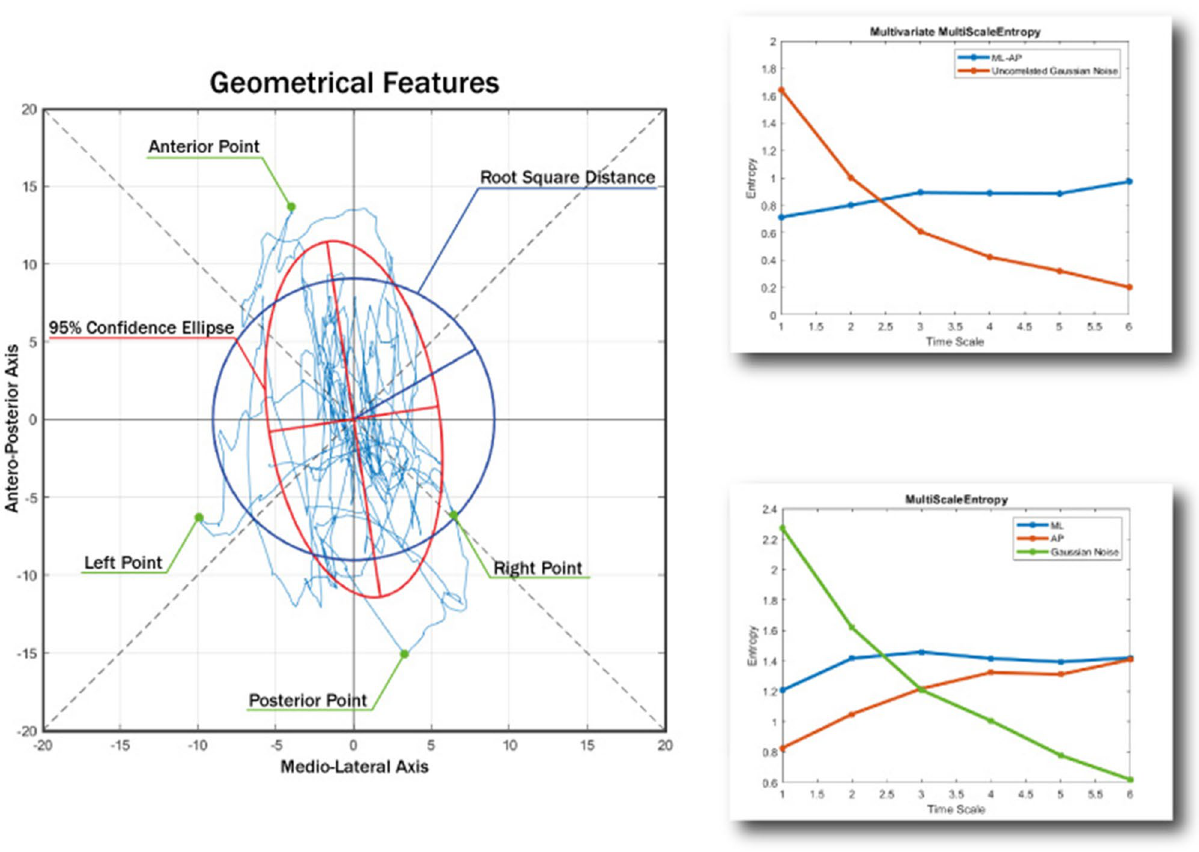
Figure 9. A graphical description of the features used in the CoP analysis. A number of geometrical and spectral features were calculated for the PRE and POST stages of the experiment. The figure shows an example of a stabilogram on the left and how some features are extracted. Similarly, an example calculation of entropy features is shown on the right to give some indication of what was calculated for the entropy measures using the stabilogram